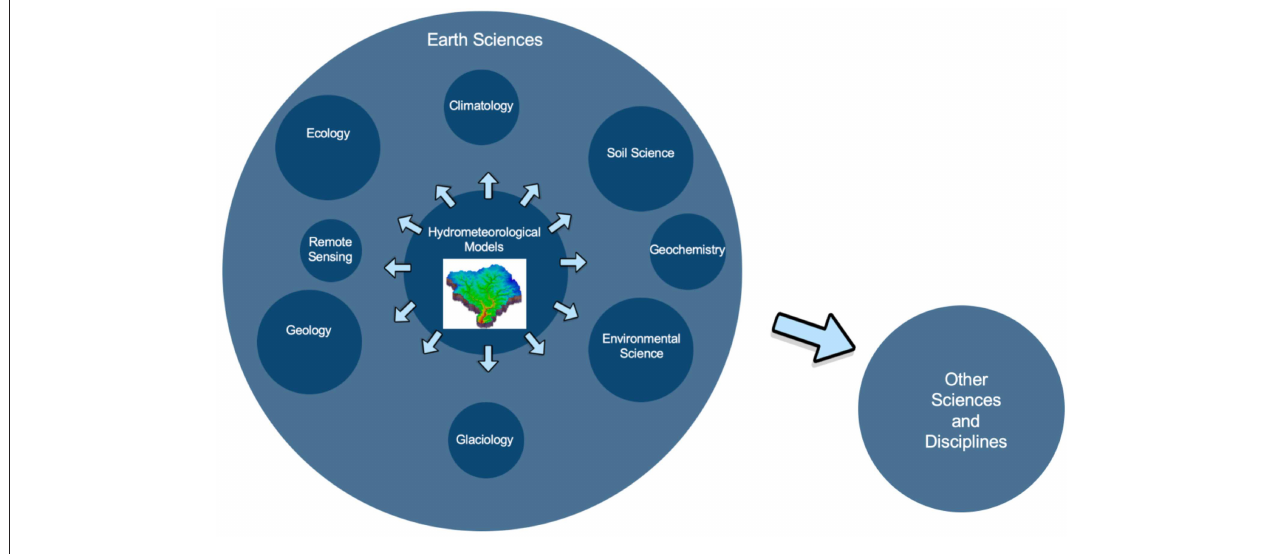
FIGURE 1 | The expansion of hydrology.